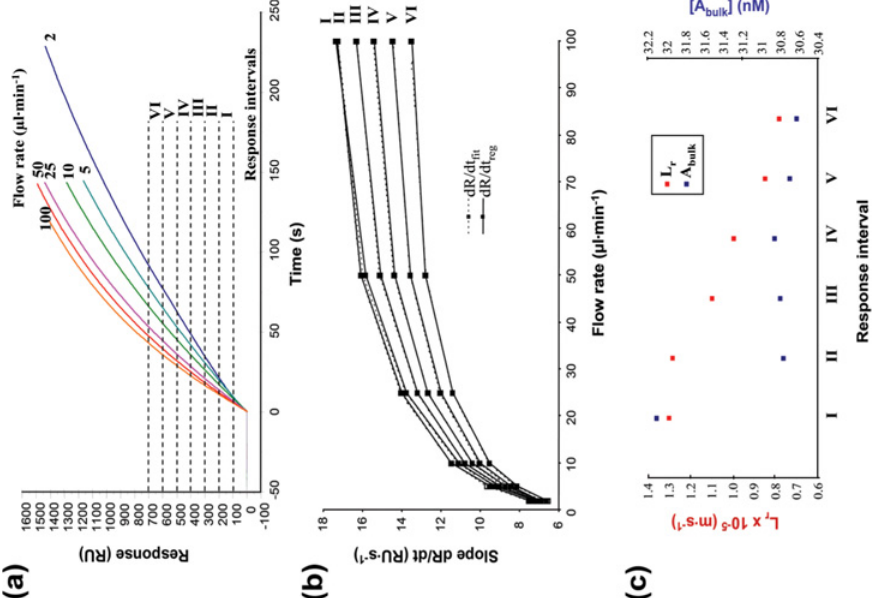
Fig 1. Calculating the concentration of active scFv. The scFv (142 nM, as determined by measuring the optical density at 280nm) was injected over a chip surface with high ligand immobilisation at several flow rates. (a) The association phase of the sensorgrams was divided into six response intervals (I-VI). (b) Comparison of the experimental (dR/dtreg) and calculated (dR/dtfit) binding rates for each response interval. (c) Lr (red) and [Abulk] (blue) were calculated by global fitting of the data at each flow rate using Eq 2, using dR/dtreg as slopes for each response interval. Lr values decrease with the increase of the response interval, while the calculated [Abulk] values are contained in a small interval (30.622 – 32.098 nM). The calculated concentration of active scFv is the average [Abulk] from each response interval: 30.97 ± 0.559 nM (SD =